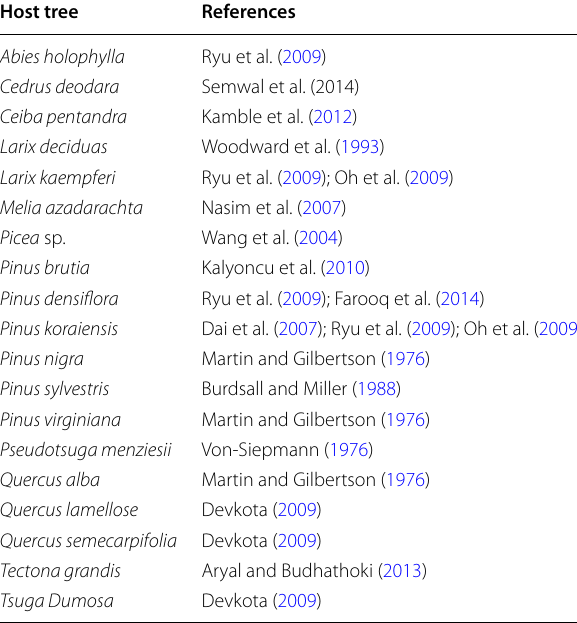
Table 1 Tree species invaded by S.